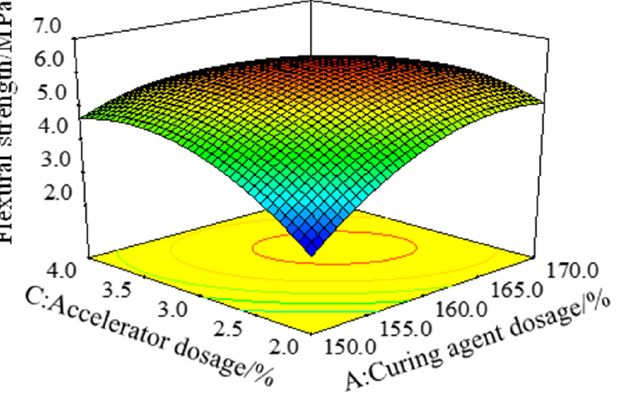
σ ) under the interaction of factors A and factor C . f